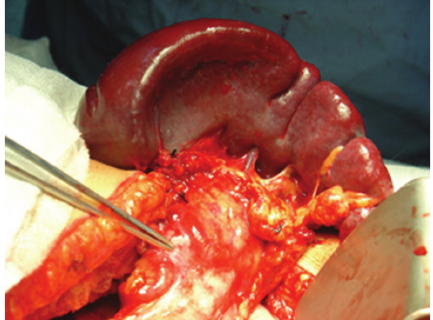
Figure 5: Glucagonoma in the tail of